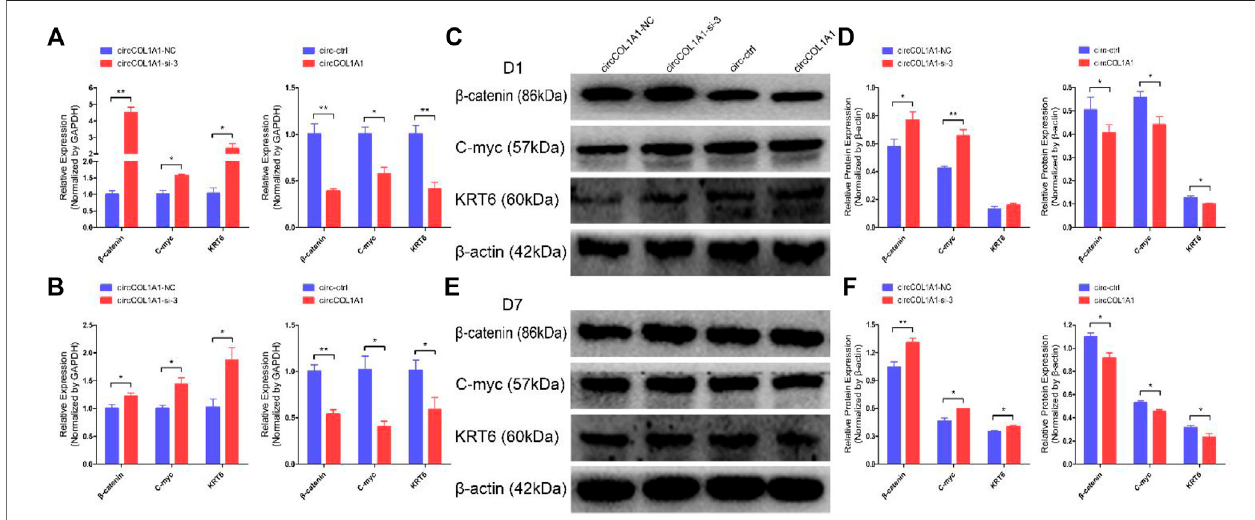
FIGURE 5 | CircCOL1A1 suppresses β -Catenin-induced goat hair follicle stem cell differentiation. (A,B) The relative mRNA expression of β -catenin, C-myc, and KRT6 at 1 day (A) and 7 days (B) after transfection with circCOL1A1-si-3 and circCOL1A1-overexpressing plasmid in β -catenin-induced hair follicle stem cells. (C,D) Protein expression of β -catenin, C-myc, and KRT6 at 1day after transfection with circCOL1A1-si-3 and circCOL1A1-overexpressing plasmid in β -catenin-induced hair follicle stem cells. (E, F) Protein expression of β -catenin, C-myc, and KRT6 at 7 days after transfection with circCOL1A1-si-3 and circCOL1A1-overexpressing plasmid in β -catenin-induced hair follicle stem cells. (G,H) β -Catenin protein expression during β -catenin-induced hair follicle stem cell differentiation was detected after 7 days using animmuno fl uorescence assay after transfection with circCOL1A1-si-3 and circCOL1A1-overexpressing plasmid. (I,J) C-myc protein expression during β - catenin-induced hair follicle stem cell differentiation was detected after 7 days using an immuno fl uorescence assay after transfection with circCOL1A1-si-3 and circCOL1A1-overexpressing plasmid. (K,L) KRT6 protein expression during β -catenin-induced hair follicle stem cell differentiation was detected after 7 days using an immuno fl uorescence assay after transfection with circCOL1A1-si-3 and circCOL1A1-overexpressing plasmid.